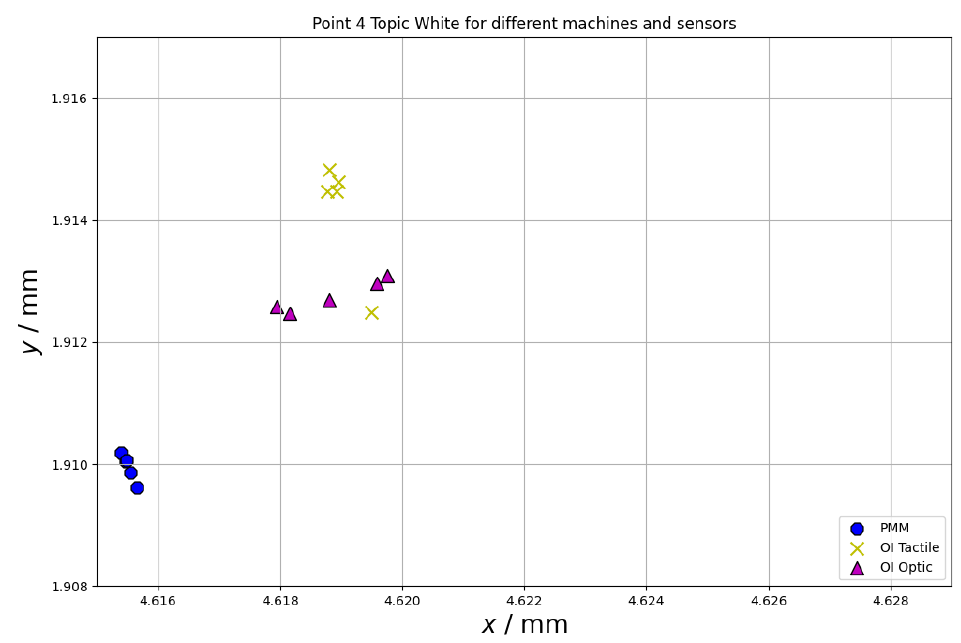
Figure 9. Repeatability of measuring point for chosen point at the equator of the sphere made of Topic White.